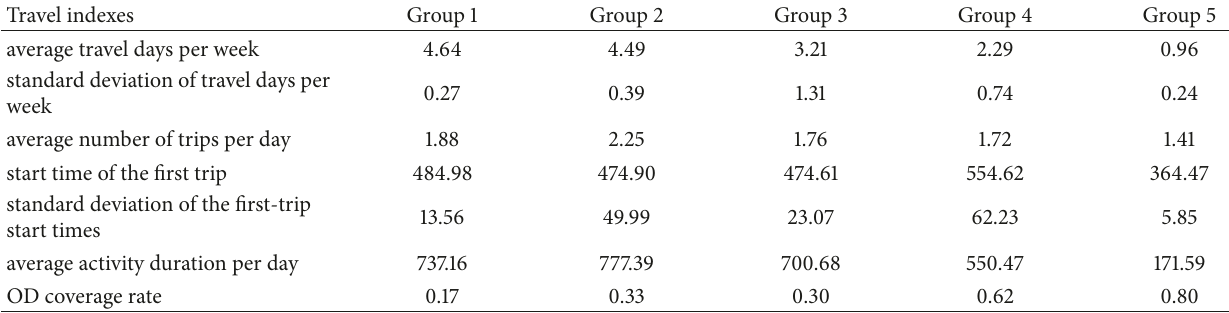
Table 6: Center point for each group.